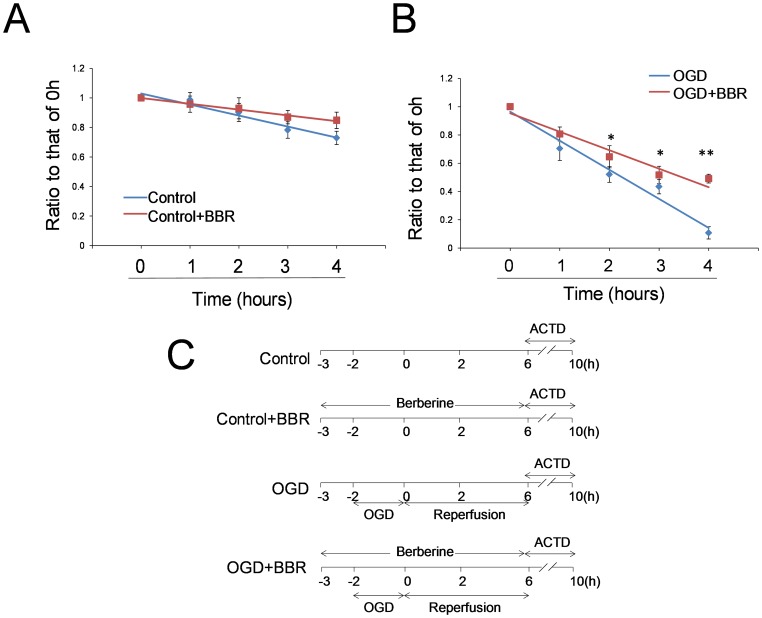
Effects of berberine (BBR) on the degradation of RB1 mRNA in normal and OGD conditions.(A) The time-dependent degradation of RB1 mRNA level detected using real-time PCR. (B) The time-dependent degradation of RB1 mRNA level with OGD detected using real-time PCR. (C) The experimental schedule. BBR (0.5 µg/ml) was added in the culture 1 h before OGD treatment and throughout the reperfusion time. Actinomycin D (ACTD) was 2 µg/ml. After ACTD added in culture, the cells were harvested at 0 h, 1 h, 2 h, 3 h, and 4 h for RNA detection. Data were presented as ratio to that of 0 h (ΔCp/Cp0 h). The linear equations are as follows: (A) Control, y = −0.075x+1.104, R2 = 0.9505; Control+BBR, y = −0.039x+1.038, R2 = 0.9839. (B) OGD, y = −0.206x+1.17, R2 = 0.9679; OGD+BBR, y = −0.131x+1.085, R2 = 0.9439. Data are presented as mean ± S.D. from three independent experiments (n = 3). *P<0.05, **P<0.01 v.s. OGD groups.